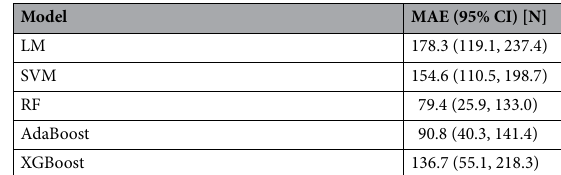
Table 1. Test set mean absolute error (MAE) and 95% confidence interval (CI) of the benchmark linear model (LM) and selected machine learning models ( SVM support vector machine, RF random forest).